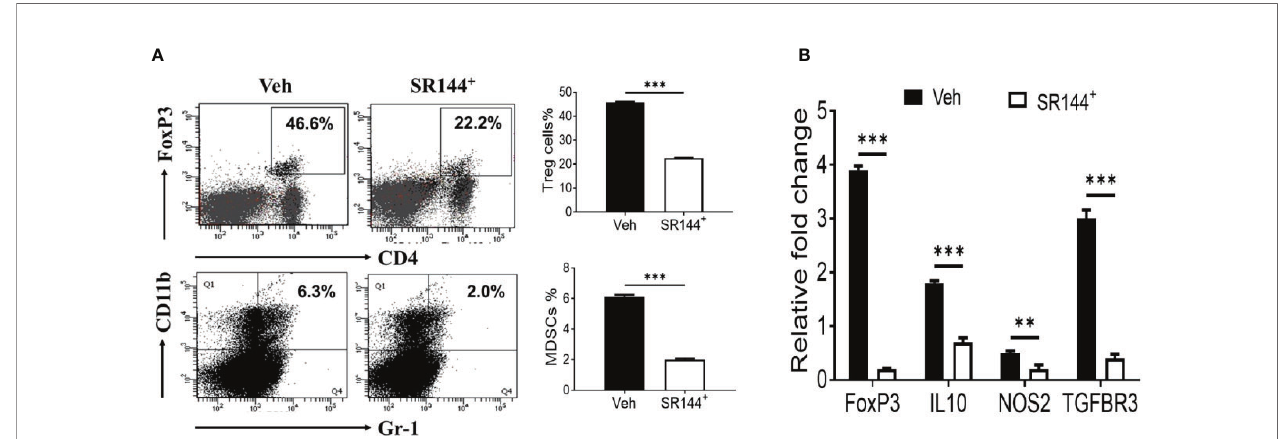
FIGURE 3 | THC promotes the generation of Tregs and MDSCs through CB2 receptor activation. Spleen cells were cultured with SEB + THC in the presence of vehicle or CB2 antagonist, SR-144. (A) shows in vitro generation of Tregs and MDSCs in the presence of vehicle or CB2 antagonist (SR144). Vertical bars show data from four mice with Mean ± SEM. (B) Expression of genes (FoxP3, IL-10, NOS2, TGF- b R3) using RT-PCR in SEB + THC-activated splenocytes cultured in the presence of vehicle or CB2 antagonist (SR144). Statistical signi fi cances are depicted as **p < 0.01, ***p < 0.001 between the